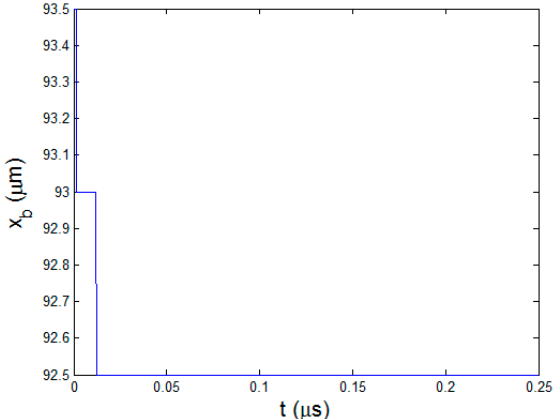
x at the cooling stage. b